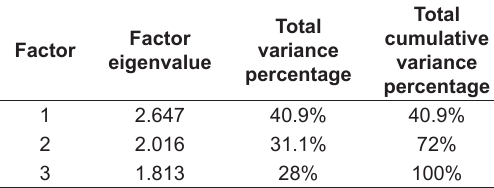
Table 5. Factor Analysis for the physicochemical variables measured: three factors have been extracted, because they had an eigenvalue greater than 1.0. It accounts for 100% of the variability in the original data.